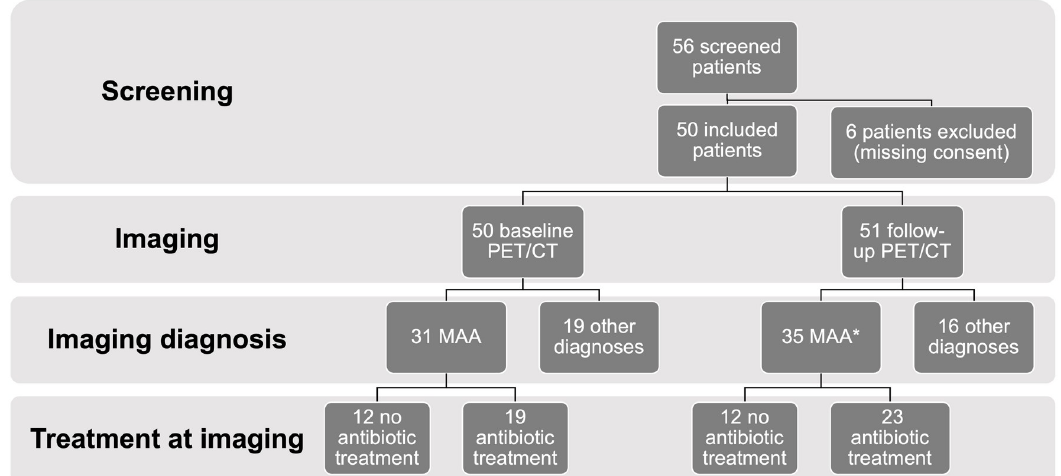
Fig 1. Flow diagram. Flow diagram displaying the numbers of patients screened, excluded, and included in the final study for suspected mycotic aortic aneurysms (MAA) in the first section. The second section shows the number of baseline and follow-up PET/CT (positron emission tomography/computed tomography) performed. Imaging diagnoses at baseline PET/CT are given in the third section, as well as the number of confirmed MAA at follow up ( � notably, repetitive imaging in some patients with MAA accounts for the higher number as compared to baseline). Finally, the number of patients treated with antibiotics at the time of imaging is given in the bottom section.